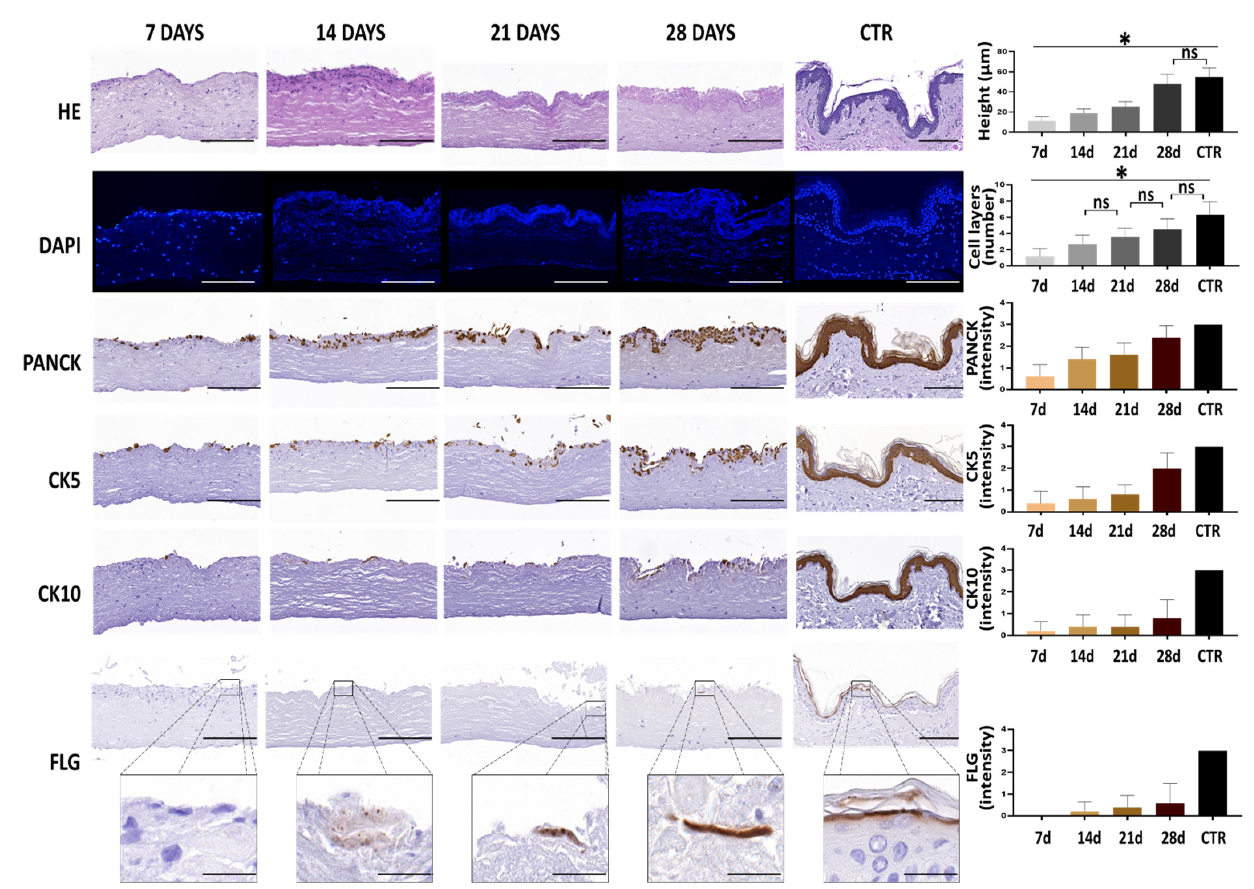
Figure 1. Histological evaluation of the epidermis of the human skin substitutes and native human skin control. The histological features of the epidermis human skin substitutes developed after 7, 14, 21 and 28 days and human controls (CTR) were evaluated with Hematoxylin-Eosin (HE) and DAPI, as well as with key epithelial markers using immunohistochemistry techniques for PANCK, CK5, CK10 and FLG. The thickness of the epidermis, the number of epithelial cell strata and the immunohistochemical positive expression were quantified and shown accordingly. Statistically significant differences between groups are labeled with asterisks (*), whereas non-significant differences are labeled with “ns”. Scale bar = 200 µm and 26 µm in the insets.